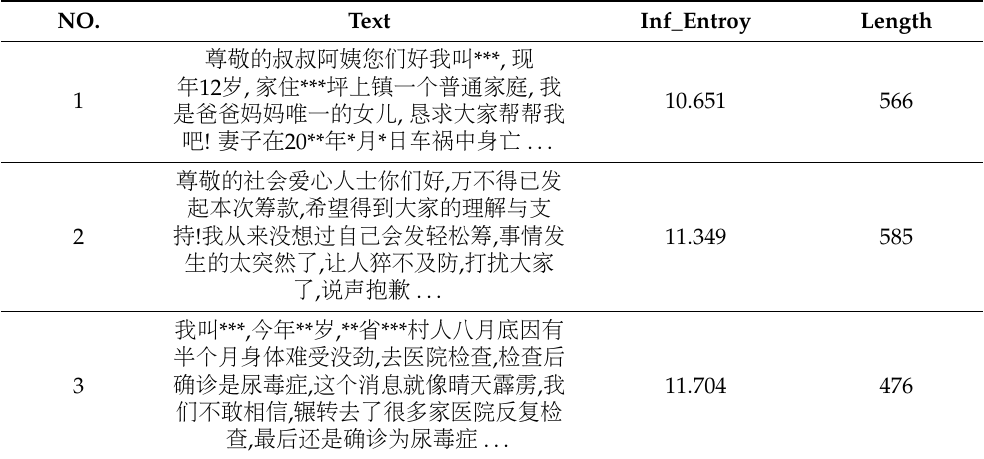
Table 2. Calculation of the information entropy of texts. NO. Text Inf_Entroy Length